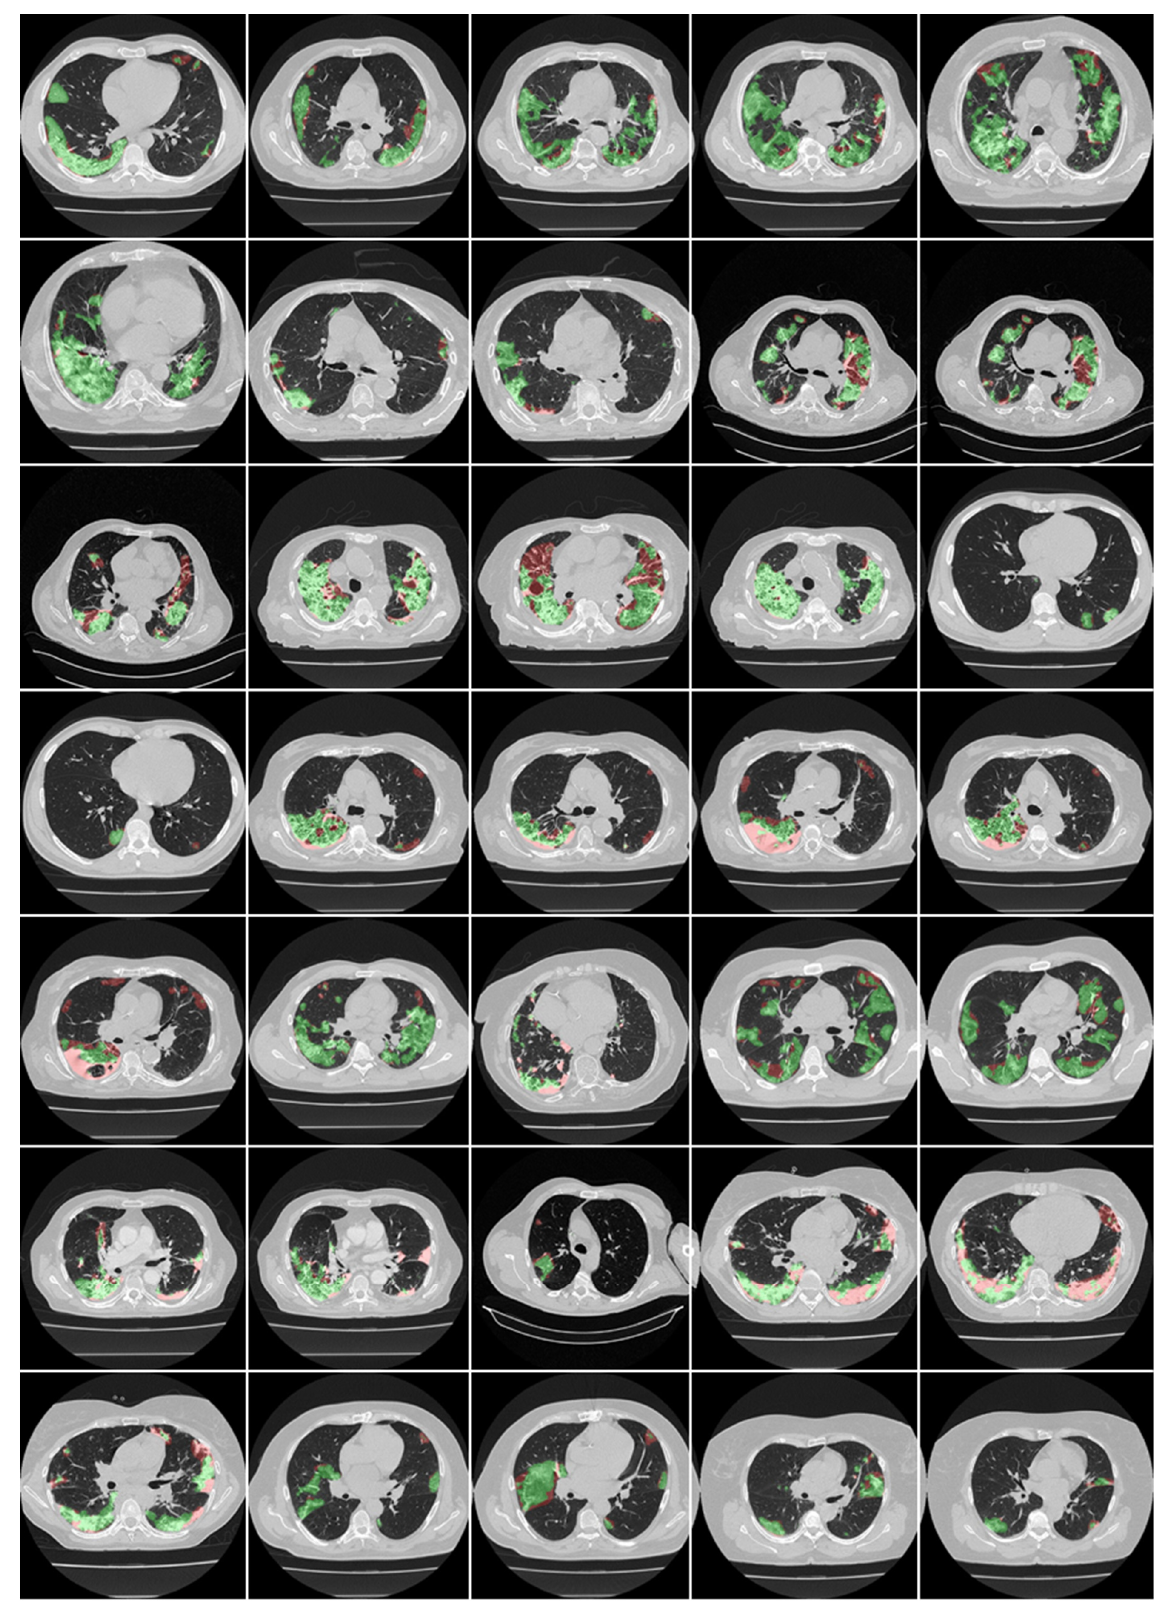
Figure A4. Results of visual lesion overlays showing VGG ‐ UNet (green) vs. MD 1 (red).